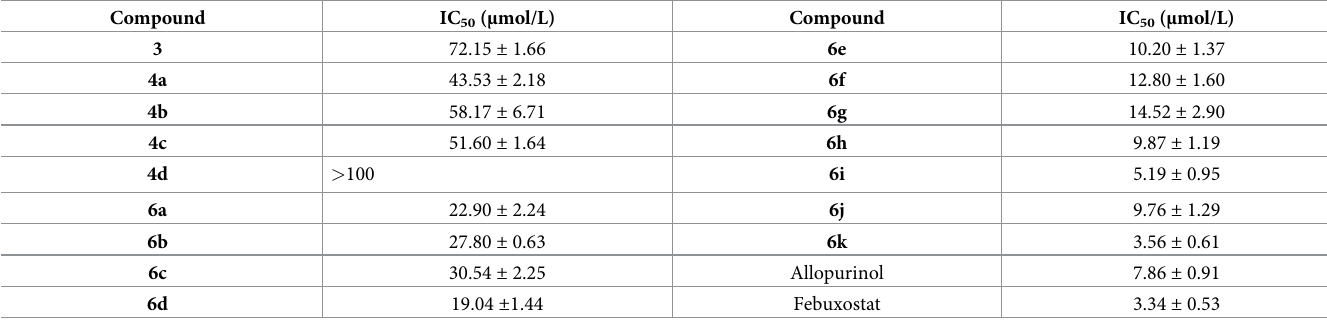
Table 1. In vitro XO inhibitory potency of thiazolidine-2-thione derivatives.